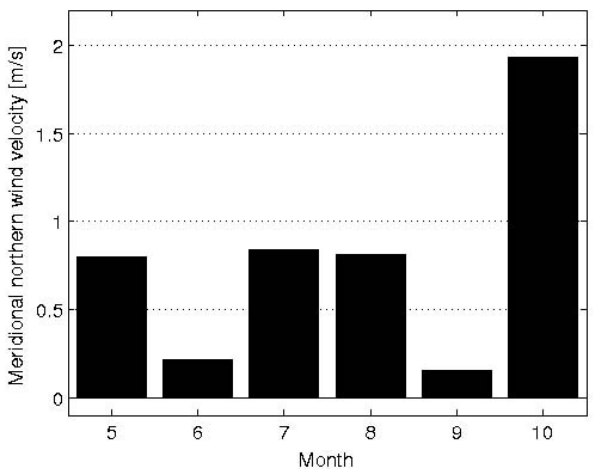
Fig. 10. Monthly variability of meridional northern wind velocity averaged over the Tehuantepec Jet sub-region during the rainy sea- sons of years 2000–2009.